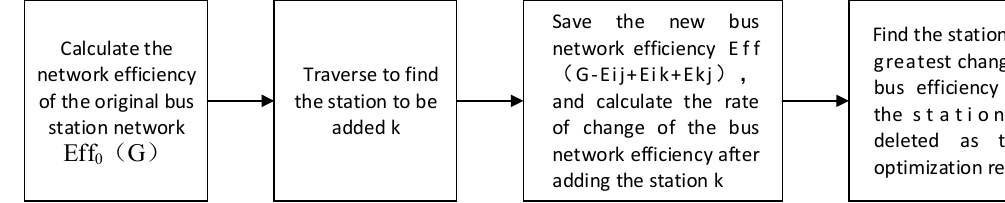
Figure 6. Add bus stations.